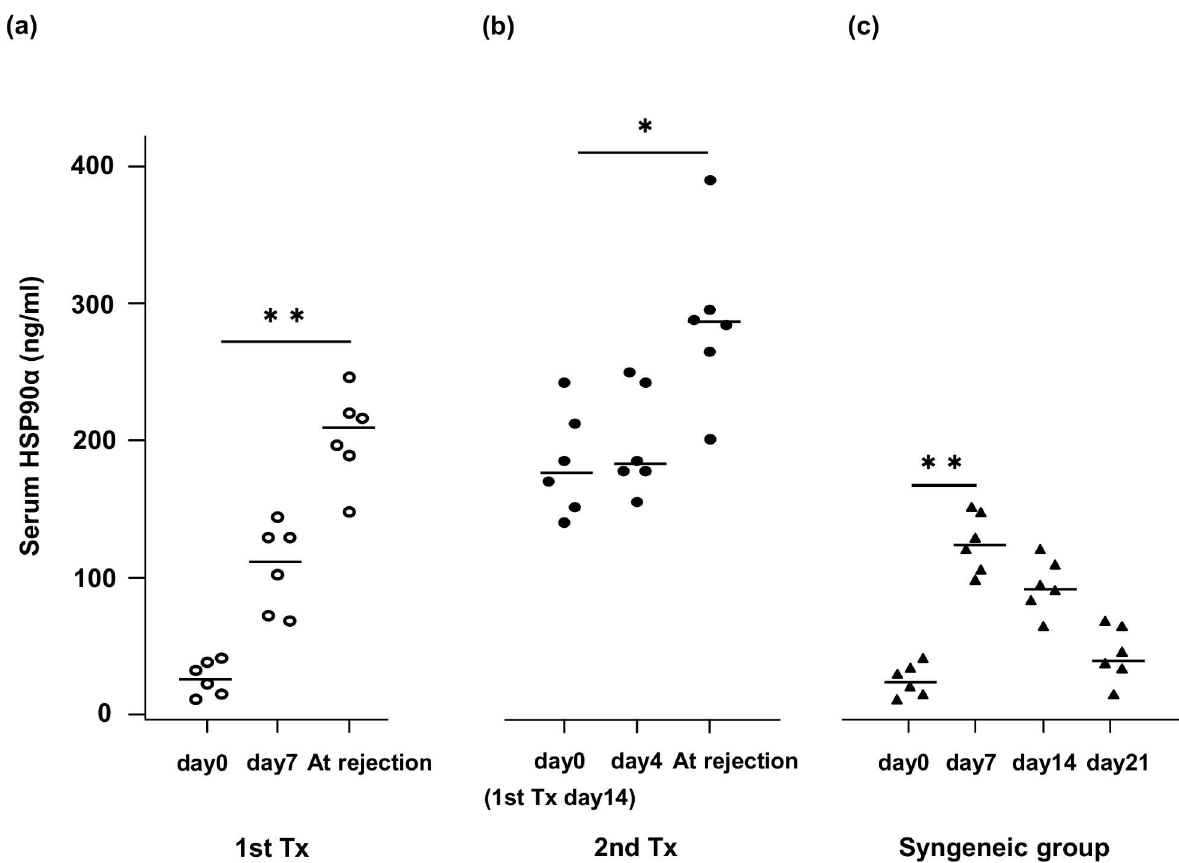
Fig 8. Scatterplotsof serum HSP90 α in skin transplantationof mice. Survivingmice were sacrificed and theirsera were tested by ELISA. Each dot shows an individualresult;bars representthe median.(a) The serumHSP90 α level increasedafterfully mismatched skin transplantation. (b) In the second graft recipients, serumHSP90 α was elevated at the timeof rejectionas comparedto the timeof rejectionof the first graft. (c) In the syngeneicgroup, the serumHSP90 α showed temporaryelevation on day 7, and then gradually decreased to the baselinelevel. * p < 0.05, ** p <